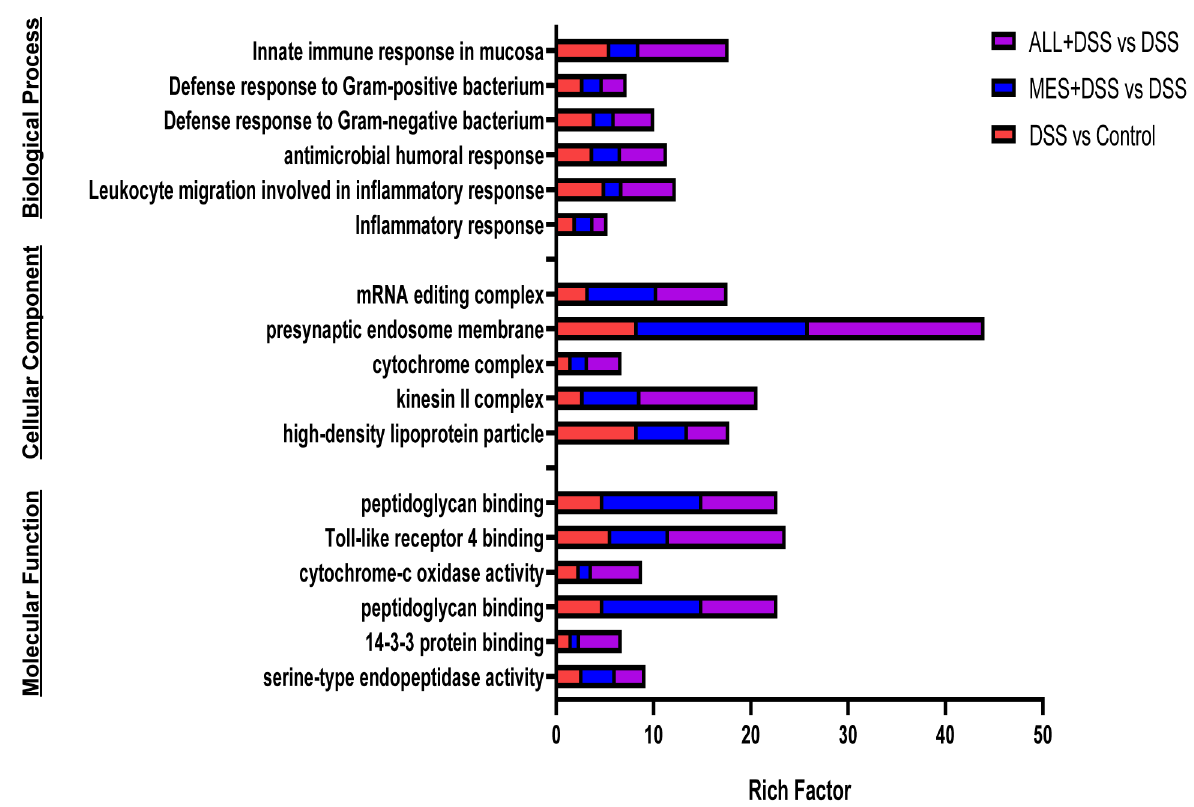
Figure 5. GO enrichment analysis of differentially expressed proteins (DEPs). The y-axis represents GO terms, including BP, CC, and MF, and the x-axis shows the rich factor in different treatments compared with the DSS.